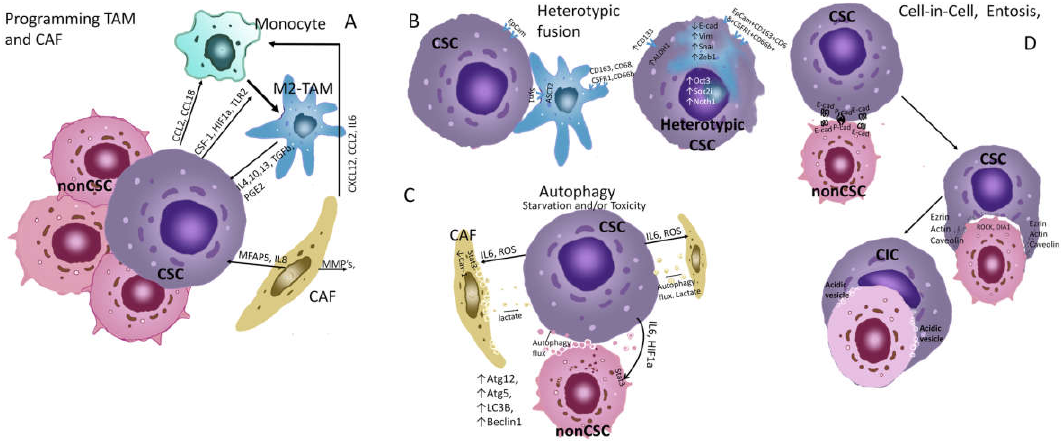
Figure 2. Ecological behaviour of CSCs, autophagy and entosis. ( A ) Programming TAM and CAF. Activation of ERK/STAT3 signaling molecules triggers M2 polarization of monocytes in breast tumours [86]. The recruitment of monocytes from the blood is carried out due to the production of chemokines—CCL2, CCL18, and cytokines CSF1, VEGF, etc., by tumor cells. When polarizing monocytes in M2-TAM CSC, CSF1, HIF1a, TLR2, and other factors are used. [87]. CAF could promote monocyte recruitment toward cancer cells through CXCL12/CXCR4 pathway [88]. CAF produces MMPs that degrade the matrix and promote invasion of CSCs. CAFs produce IL17a which stimulates symmetric division of CSCs [89]. M2-TAMs produce IL4, 10, 13, TGFb, and PGE2, which act on CSCs and stimulate their symmetric division, increasing their population [90]. Thus, this type of relationship can be seen as a commensalism between TAM, CAF, and CSCs. The interaction between TAM and CSCs is described in detail in the overview [91]. ( B ) Heterotypic fusion. Heterotypic fusion cells expressed the tumour marker EpCam and macrophage markers CD163, CD68, CSFR1 and CD66b [92]. The hybrid cells display EMT with a significant downregulation of E-cad and upregulation of N-cad, Vim and Snail, as well as an obviously increased expression of MMP-2, MMP-9, uPA, and S100A4. The TCF/LEF tran- scription factor activity of the Wnt/β-catenin pathway and the expression of its downstream target genes in- cluding cyclin D1 and c-Myc increased in the hybrid cells [93]. This type of relationship can be viewed as a symbiosis with the acquisition of new properties that are not characteristic of individual populations. ( C ) Au- tophagy. With the induction of autophagy in CSCs, the expression of ATG5-12 LC3B, and BECLIN1, as well as the transcription factors FOXO3A, SOX2, NANOG, and STAT3, which can lead to the induction of the stem phenotype, increased resistance to chemotherapy, EMT, increased migration activity, and survival of dormant cells [94,95] [96,97]. Under starvation and toxicity, CSCs can also induce autophagy of neighboring microenvi- ronmental cells and non-CSCs, through exposure to ROS, IL6, and HIF1a. In this case, cells produce metabo- lites that feed CSCs, in particular lactate [94]. In this case, the behavior of CSCs can be seen as parasitism. ( D ) Cel-in-Cell. E-cadherin and P-cadherin are key components of the adherent junctions of cells in entosis process [98]. These molecules bind CSCs and non-CSCs scavenged. Increased RHO–RHO-associated coiled-coil-con- taining protein kinase (ROCK) and/or diaphanous-related formin 1 (DIA 1)–actomyosin show in losers cells